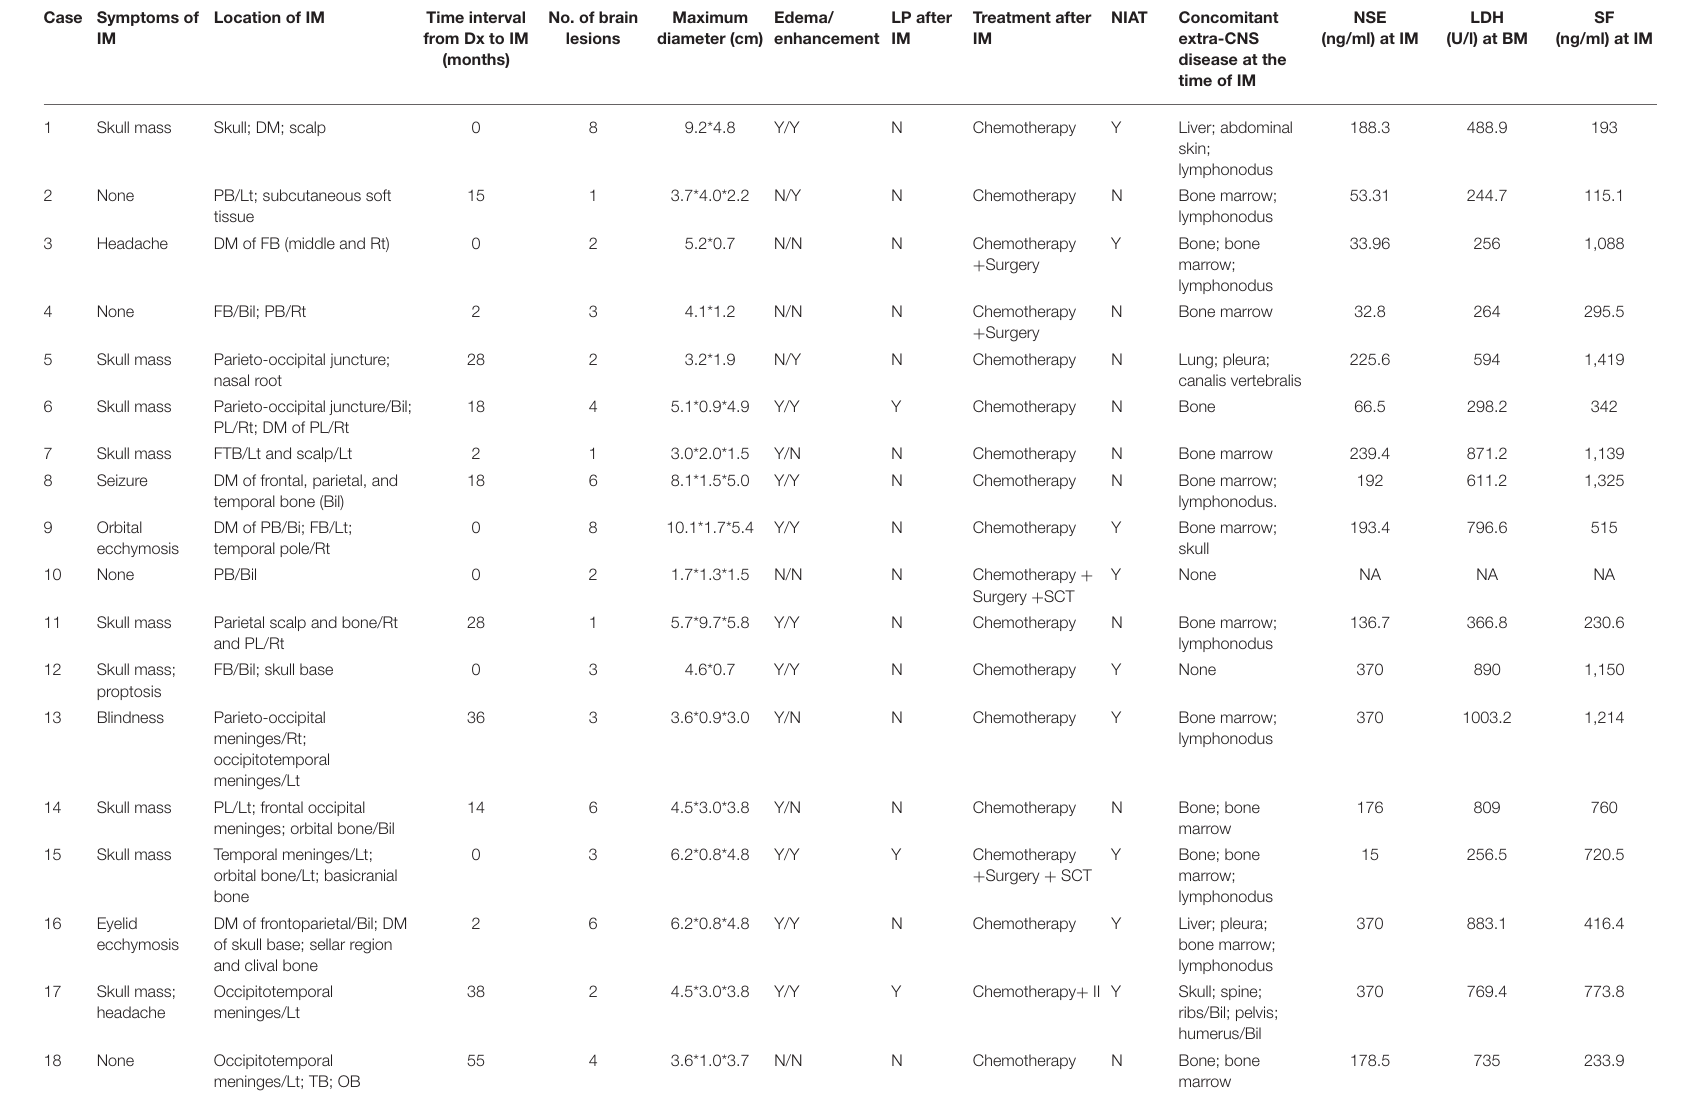
TABLE 3 | Clinical characteristics of patients at the diagnosis of NB with IM. Case Symptoms of